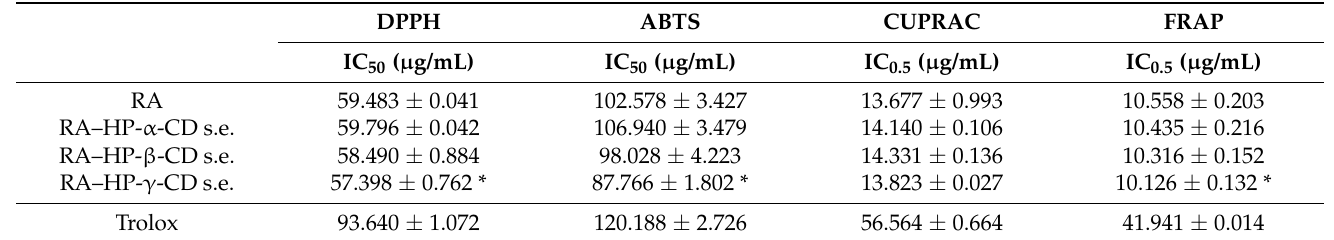
Table 2. The results of the antioxidant activity of RA and the systems (assessed as prepared concen- trations). (*) indicates statistically significant differences, p < 0.05. DPPH ABTS CUPRAC